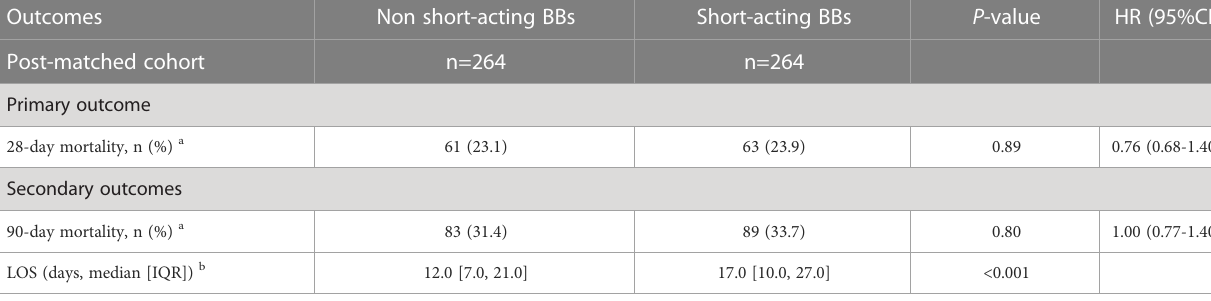
TABLE 3 Association between short-acting b -Blockers therapy and clinical outcomes in sepsis.